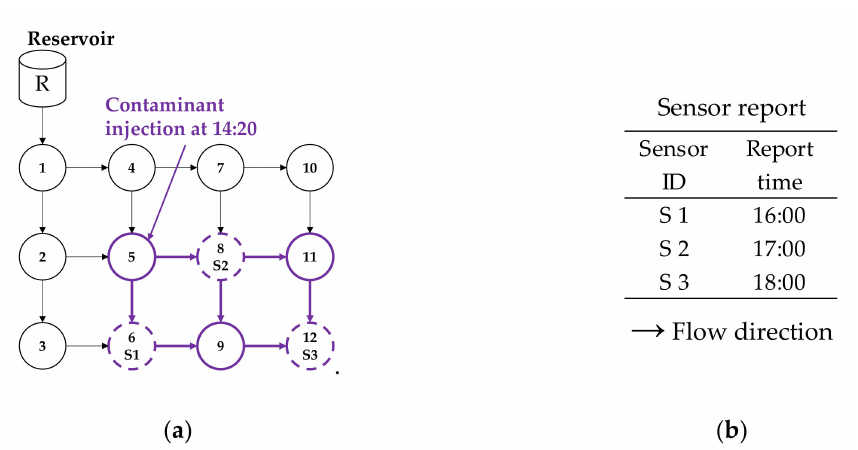
Figure 3. Calculation flowchart of the spatial filter.